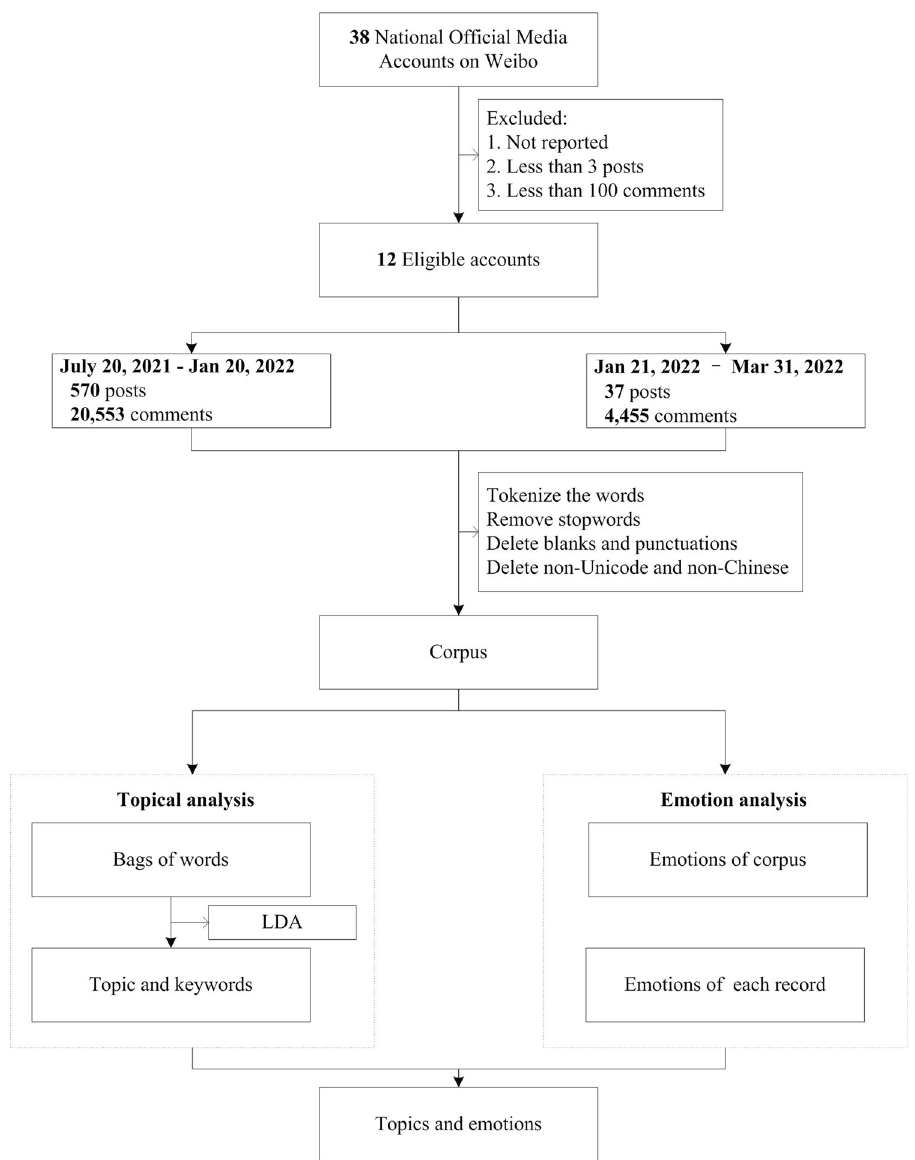
Fig. 1 Data collection and processing fl